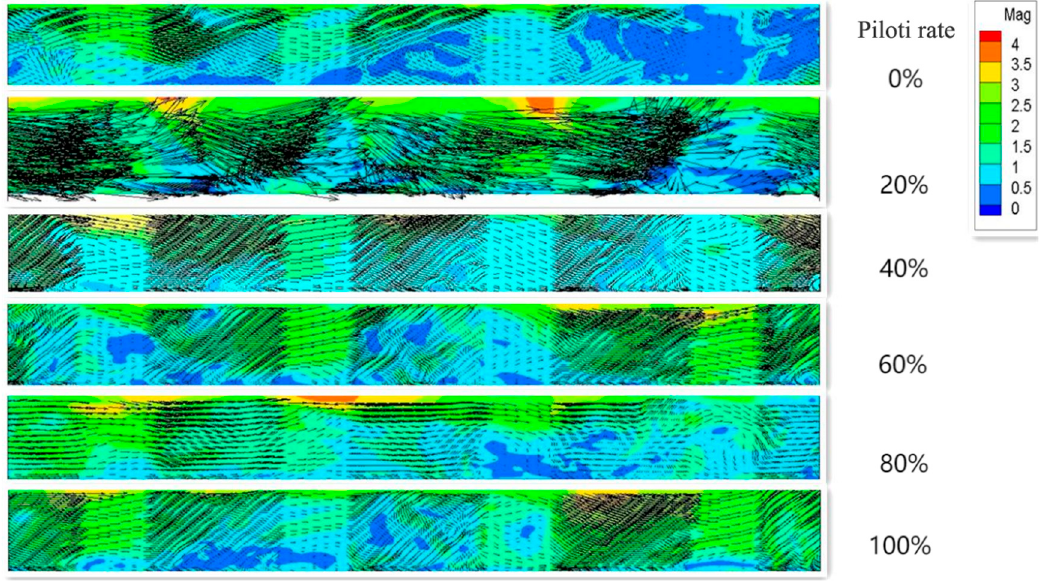
Figure 15. Vector diagram of the target area of Section 2 (Point model).